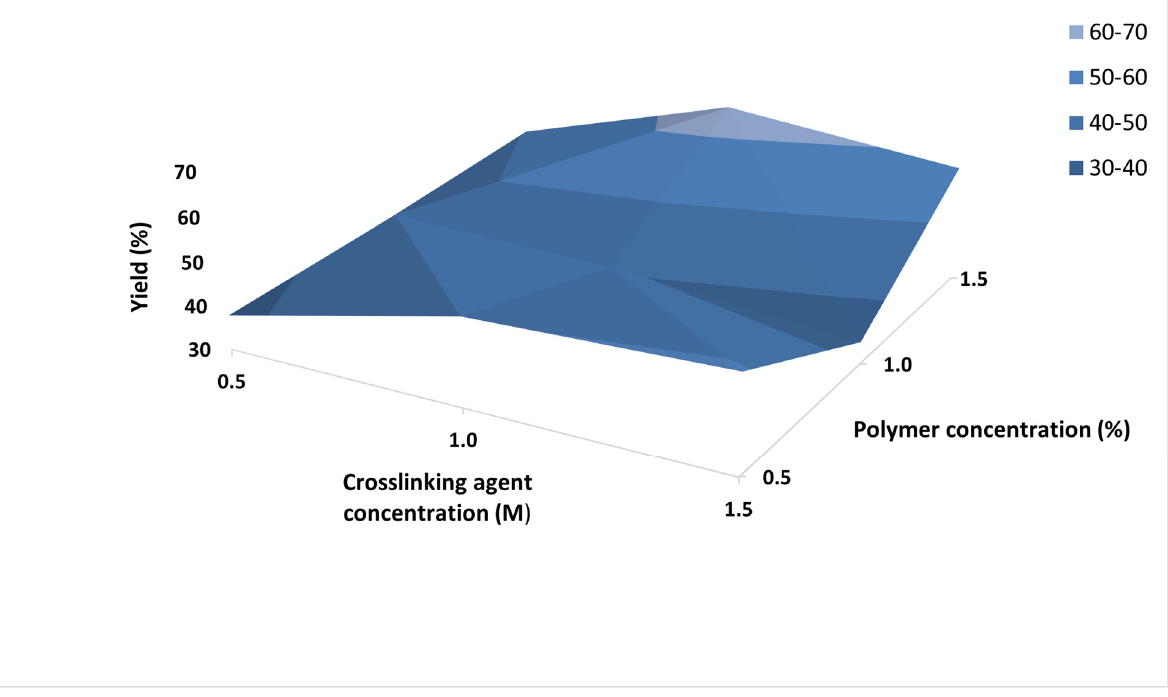
Figure 2. 3D plot representing the impact of the concentration of the polymer (%) and the crosslinking agent (M) on the particles production yields.